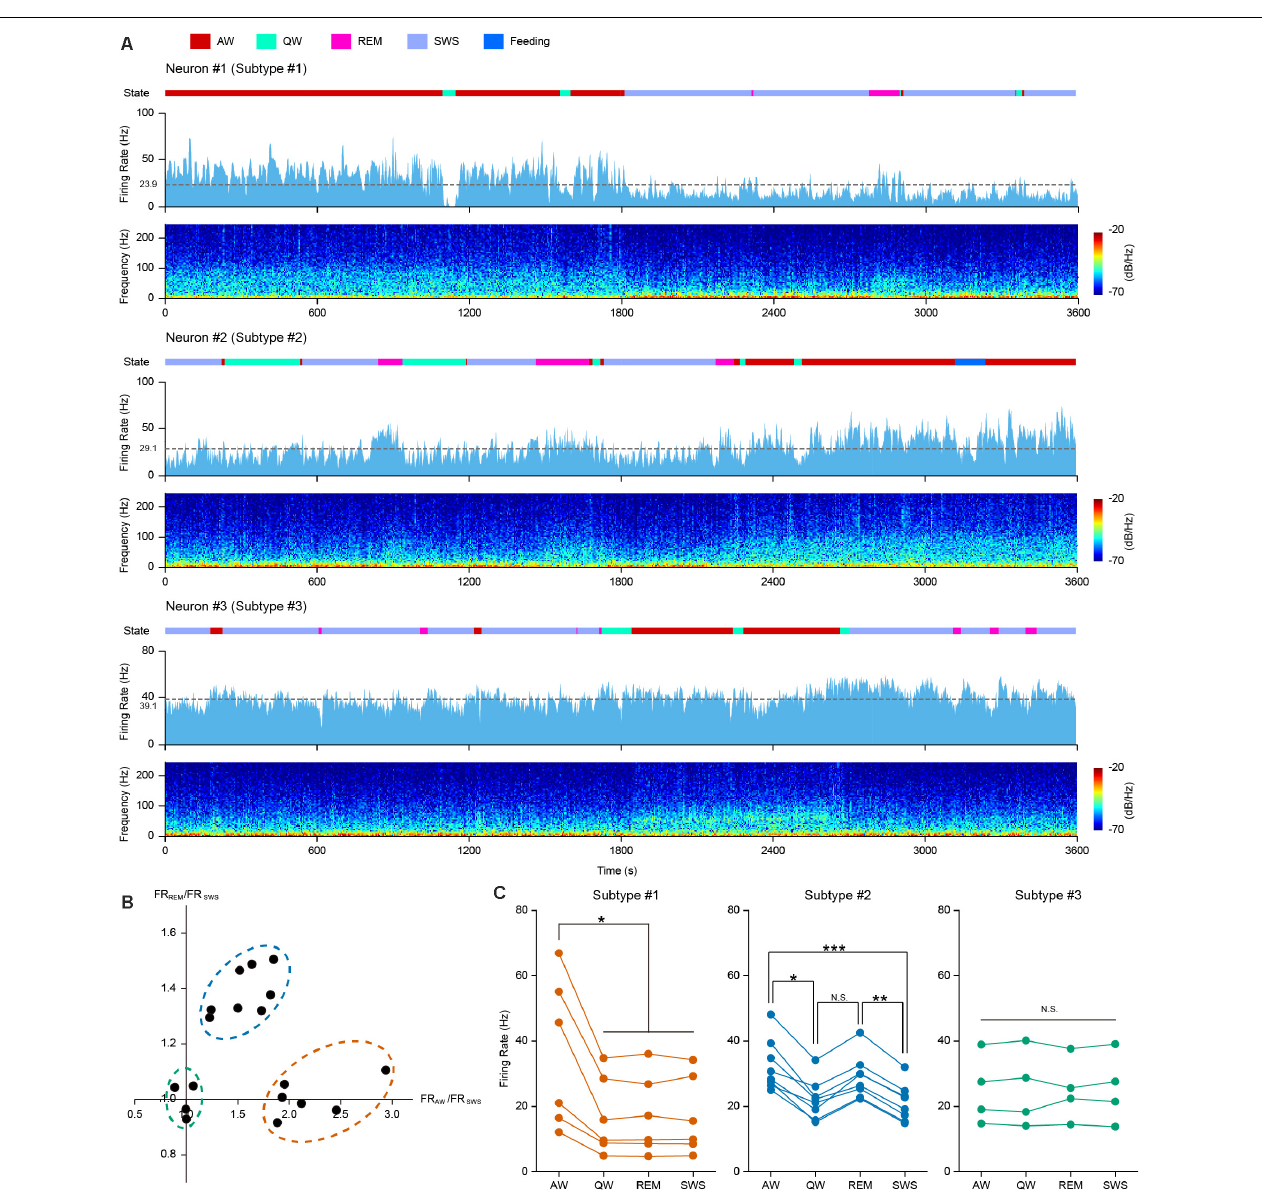
FIGURE 2 | PFC PV interneurons exhibited behavior state-dependent firing patterns. (A) One hour continuous monitoring of the firing activities of 3 example PFC PV interneurons. Each example neuron represents one interneuron subtype, showing behavior state-dependent firing patterns. Different behavioral states were associated with changes in neuronal firing rates and LFP power spectrograms. Top row, color coded behavior states (color scheme at the top of the figure); middle row, neuronal firing rate histogram (bin = 2 s) and mean firing rate (dashed gray line, average firing rate on the left); bottom row, LFP power spectrogram. (B) Relationship between FR AW /FR SWS and FR REM /FR SWS , each dot represents one opto-tagged PV interneuron. 18 PV neurons were clustered into three subtypes (shown in dashed circles. orange, subtype #1; blue, subtype #2; green, subtype #3). (C) Mean firing rate of all the 18 recorded PV interneurons under different behavior states, clustered into 3 subtypes (color coded in orange, blue and green, n = 6, 8, and 4 neurons in each subtype). Each line connecting 4 dots represents one single neuron. Note the difference in behavior state-dependent firing rate change of each interneuron subtype (Friedman Test, p subtype #1 = 0.013, p subtype #2 = 9.80e-5, p subtype #3 = 0.96; Dunn-Bonferroni post hoc , * p < 0.05, ** p < 0.01, *** p < 0.001, N.S., not